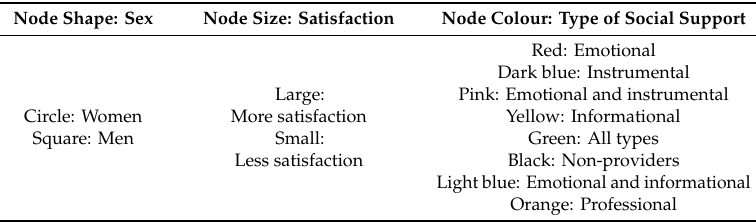
Figure 3. Graph Case 28. Man (66 years old), living with chronic pain for 35 years. Table 8. Legend of graphs.